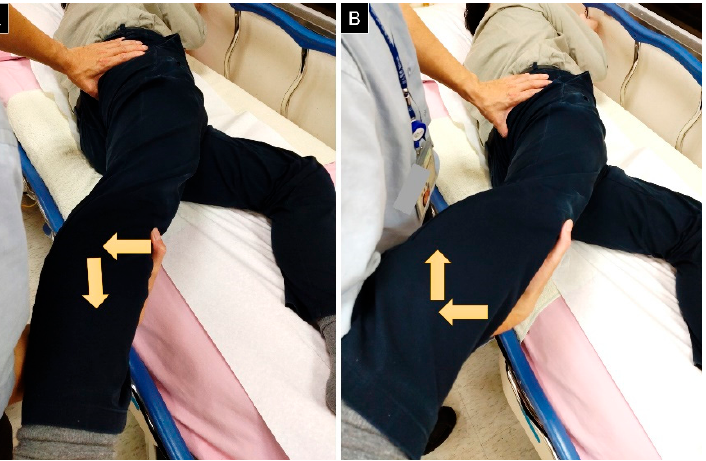
Figure 5. ( A ) Tenderness over the ischium is elicited under passive hip extension and adduction, and it disappears during ( B ) hip extension and abduction. Arrows: direction of force applied by the